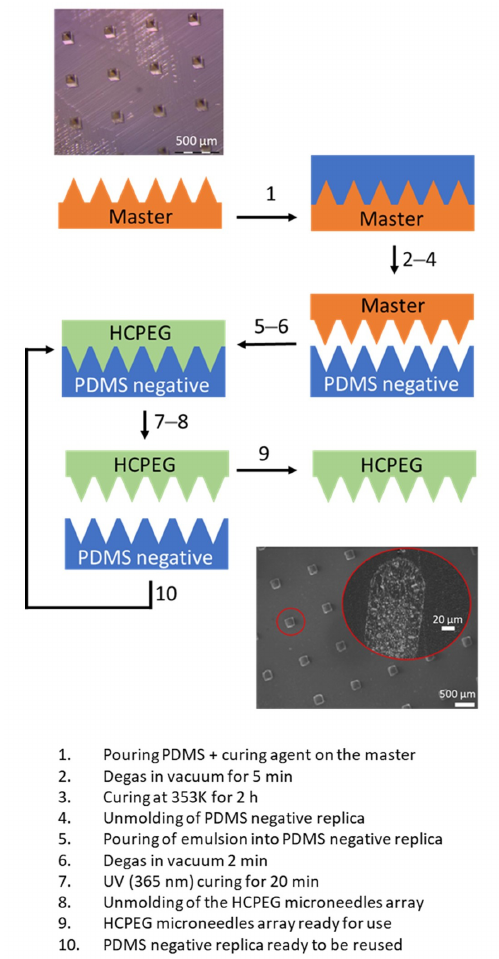
Figure 6. Schematic of the replica moulding fabrication process; optical image ( upper ) of the master microneedle array; SEM images ( bottom ) of the porous PEG microneedles array replica and inner structure of one single needle showing the